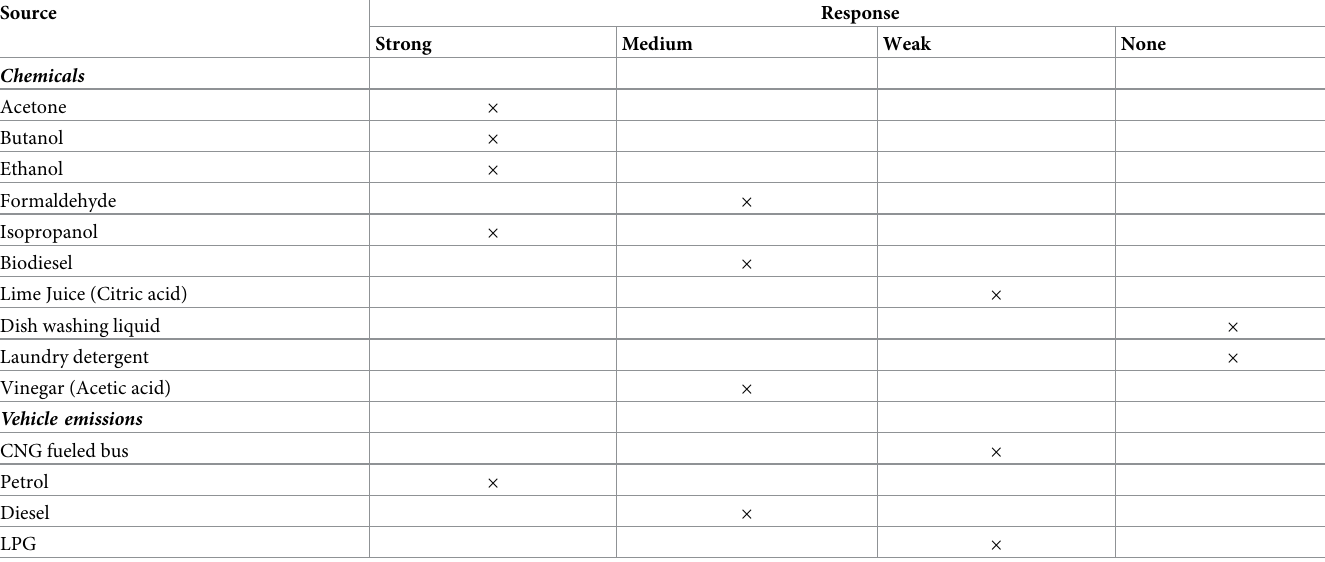
Table 2. Response of the phones to the VOC sources. Strong (readings > 2.5 ppm), medium (2.5 ppm < readings > 0.1 ppm), weak (readings < 0.1 ppm) and none (no